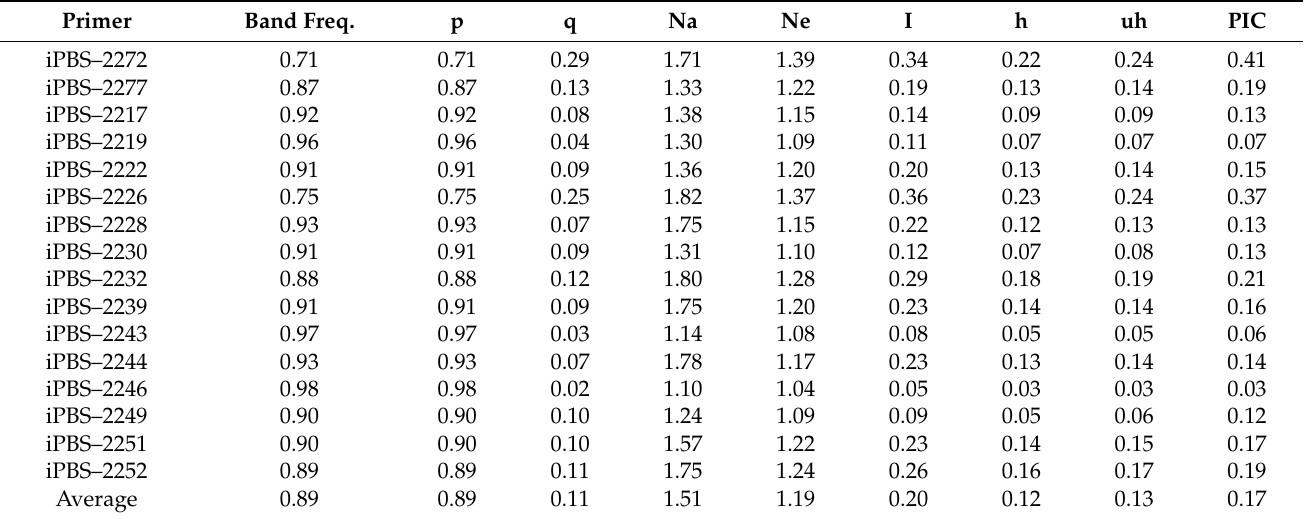
Table 5. Band frequency, number of different alleles (Na), number of effective alleles (Ne), Shannon’s information index (I), diversity (h), unbiased diversity (uh), and polymorphic information content (PIC) detected by